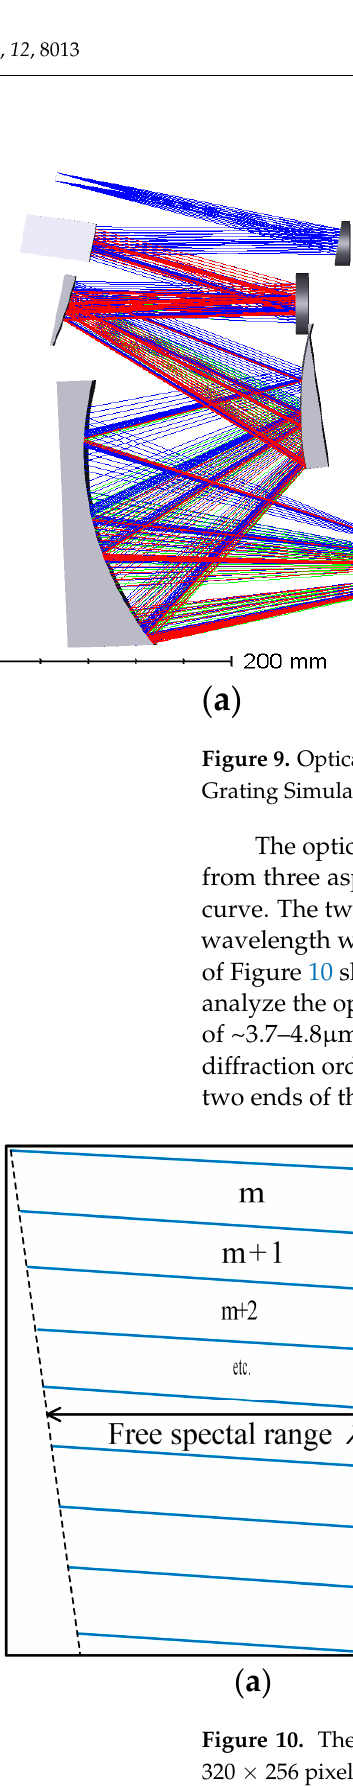
Figure 10. The echellogram in ( a ) shows the free spectral range of 36 orders on the detector of 320 × 256 pixels. The corresponding point spread function is plotted in ( b ).